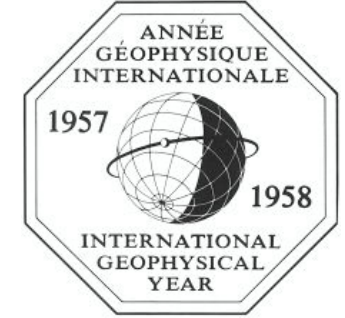
Figure 4. Emblem of the International Geophysical Year